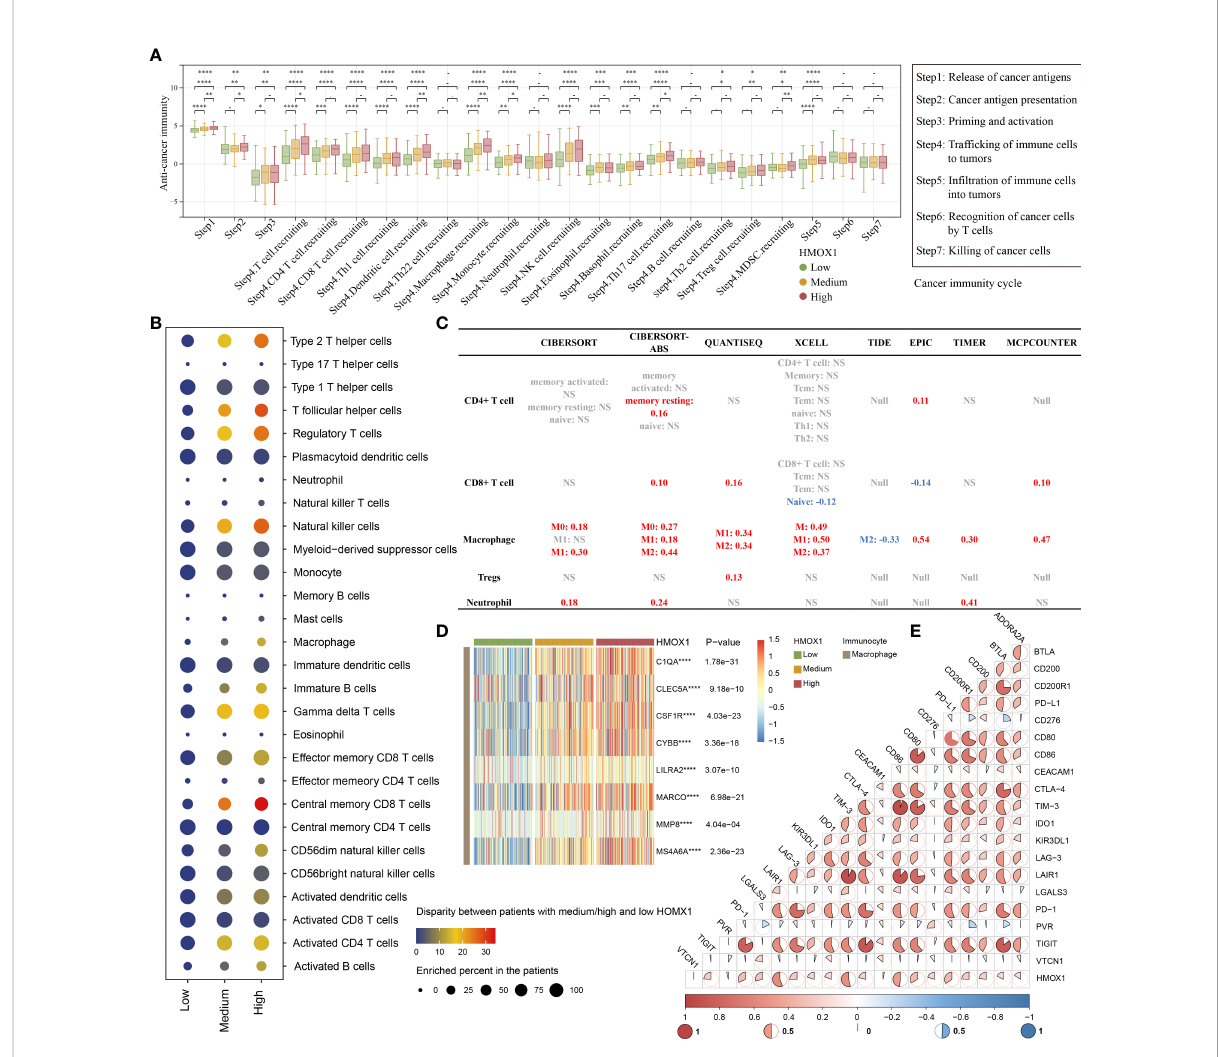
FIGURE 4 The effect of HMOX1 on the immune microenvironment in LUAD. (A) Differences in multiple steps of the cancer immunity cycles between the high, medium, and low HMOX1 groups. (B) Differences in the in fi ltration levels of 28 types of immunocytes among the high, medium, and low HMOX1 groups, which were calculated using the GSEA algorithms. (C) Correlation between HMOX1 and the in fi ltration levels of 5 types of immunocytes (CD4+ T cells, CD8+ T cells, macrophages, Tregs, and neutrophils), which were calculated using 8 algorithms. (D) Differences in the effector genes of macrophages among the high, medium, and low HMOX1 groups. (E) Correlation between HMOX1 and 20 inhibitory immune checkpoints. NS, not signi fi cant; *P < 0.05; **P < 0.01; ***P < 0.001; ****P <